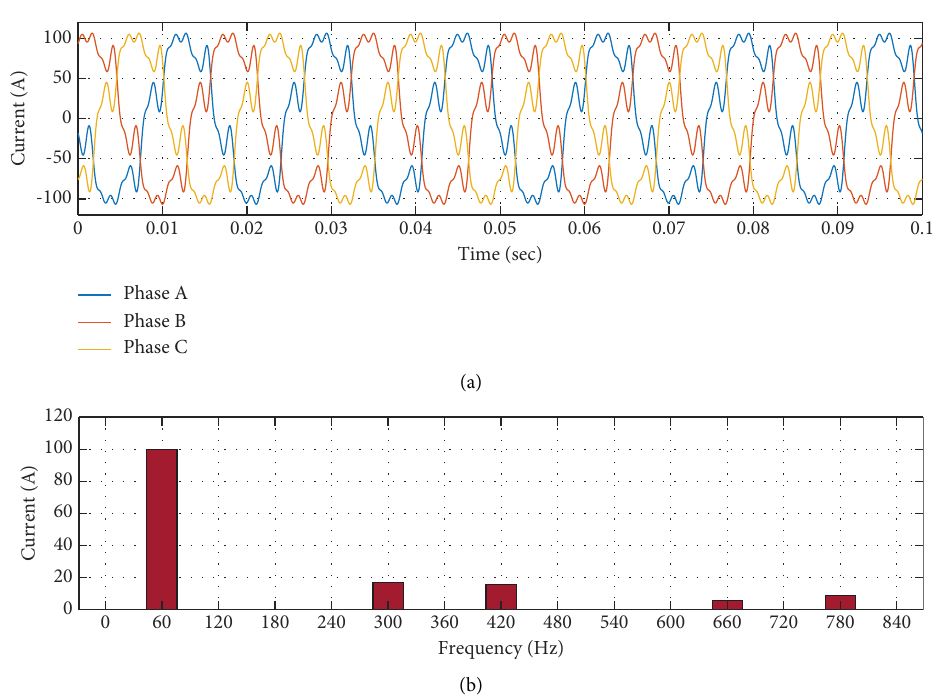
Figure 2: Injected waveform (a) and its spectrum (b).